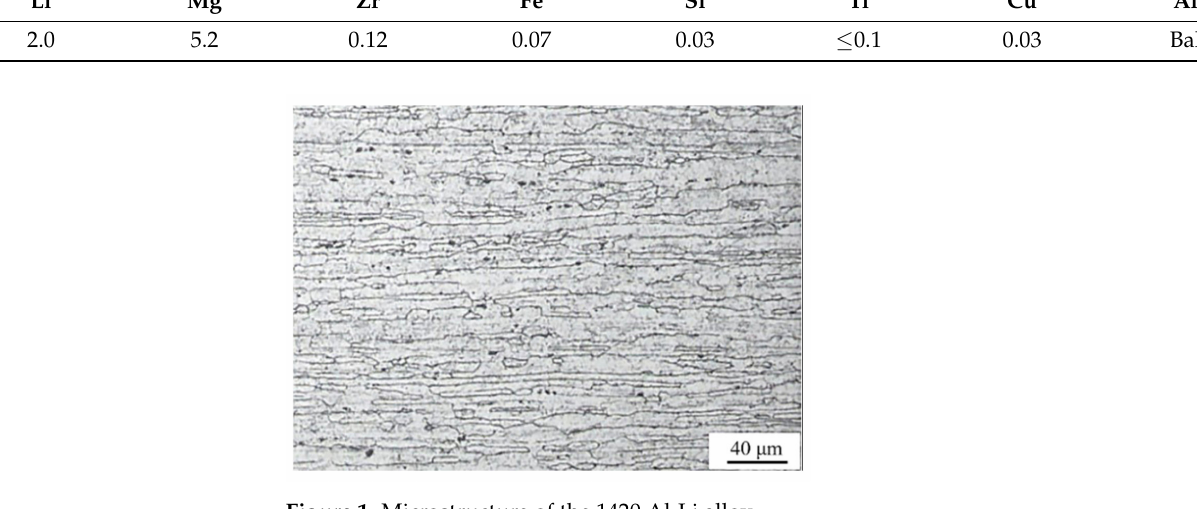
Figure 1. Microstructure of the 1420 Al-Li